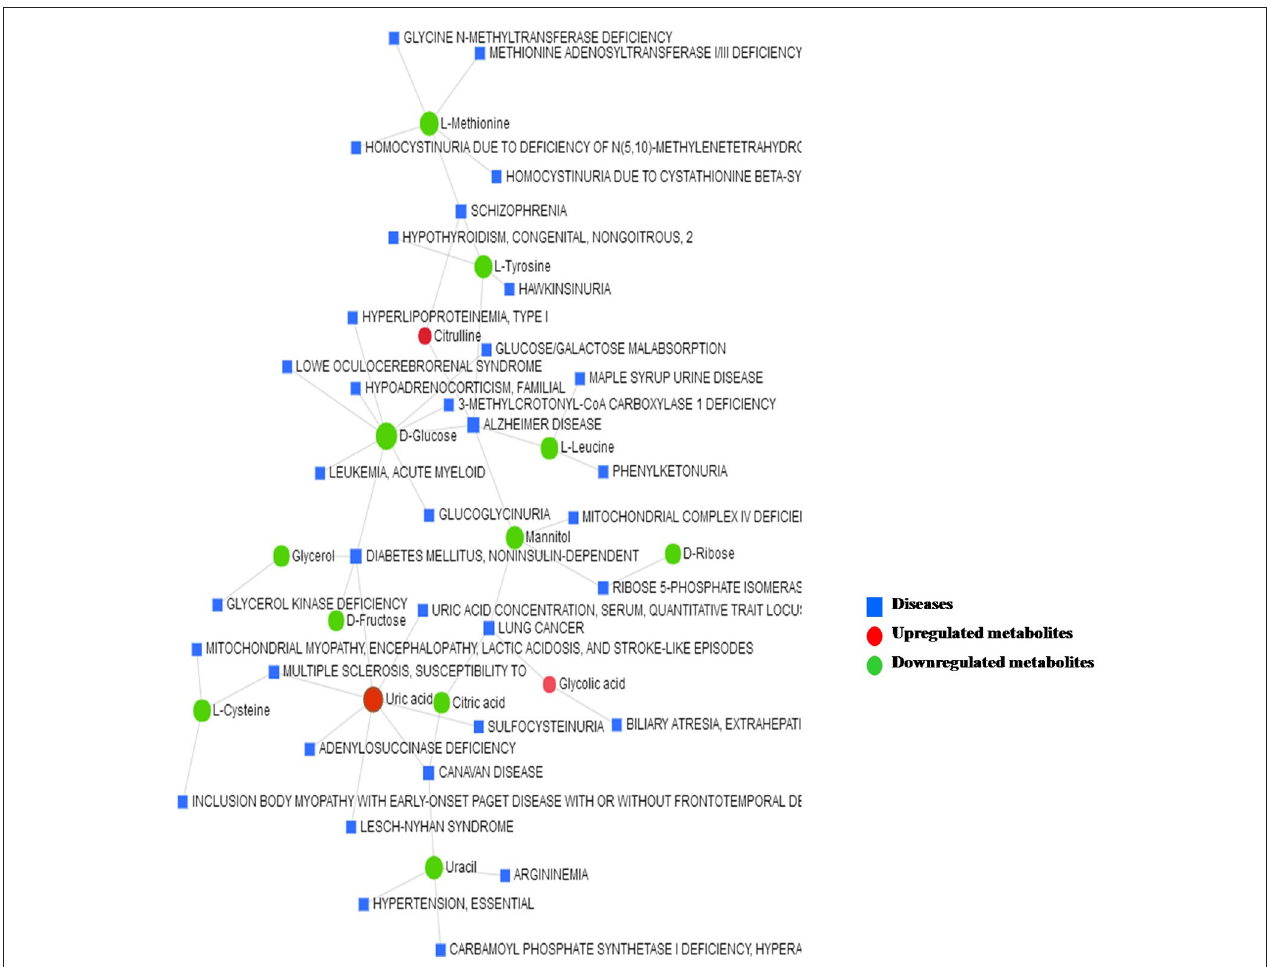
FIGURE 7 | The metabolite–disease interaction network provides a visualization of the disease-related metabolites identified from